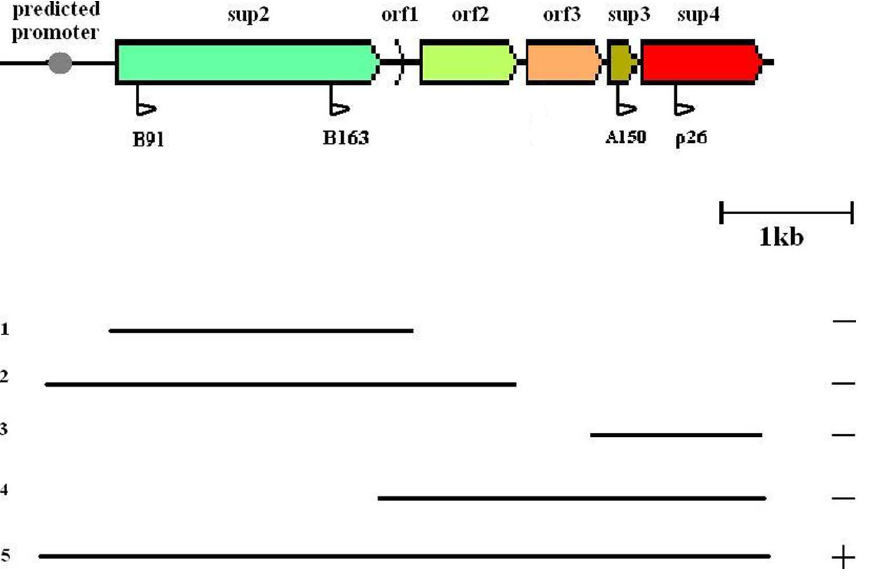
Figure 1. Complementation analysis of the PQQ biosynthesis region in Ps.fluorescens strain X. PCR fragments of this region (1–5), with different sets of genes from Ps. fluorescens X, and their ability to complement sup 2 mutants. Ability to complement is noted with plus ( + ) or minus ( 2 ). The direction of the plasposon Tn 5 -RL27 insertion in the derivative mutants B91, B163, A150 and r 26 is indicated with a flag beneath the sequence. The predicted site for the unique putative promoter is also marked.